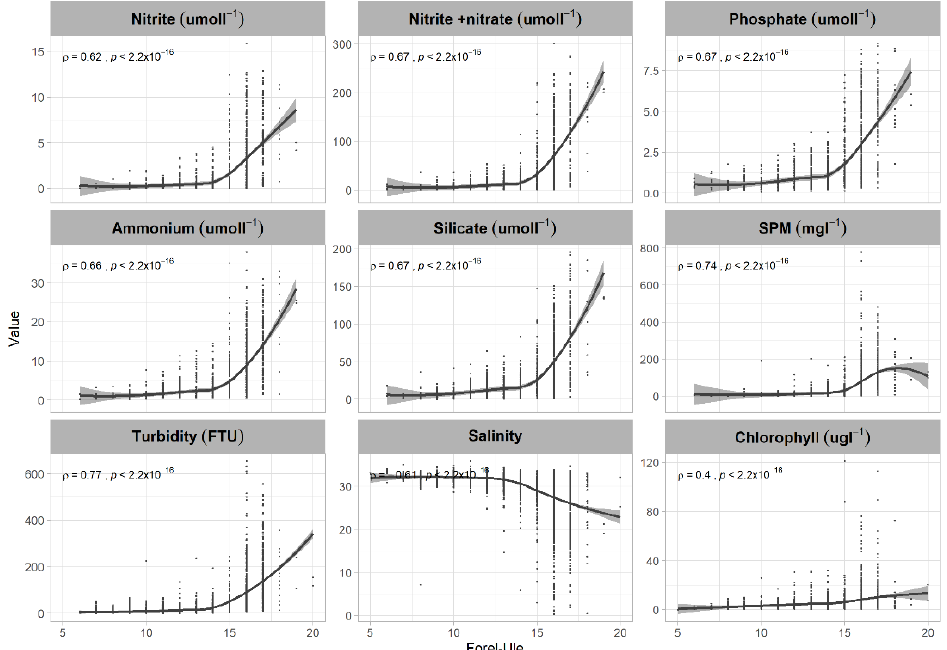
Figure 10. Spearman’s correlation ( ρ /rho) with the significance value ( p ) between the FUI values (1–21 scale) and the water nutrients, Chl-a, SPM and turbidity. The middle line shows the local regression fit.